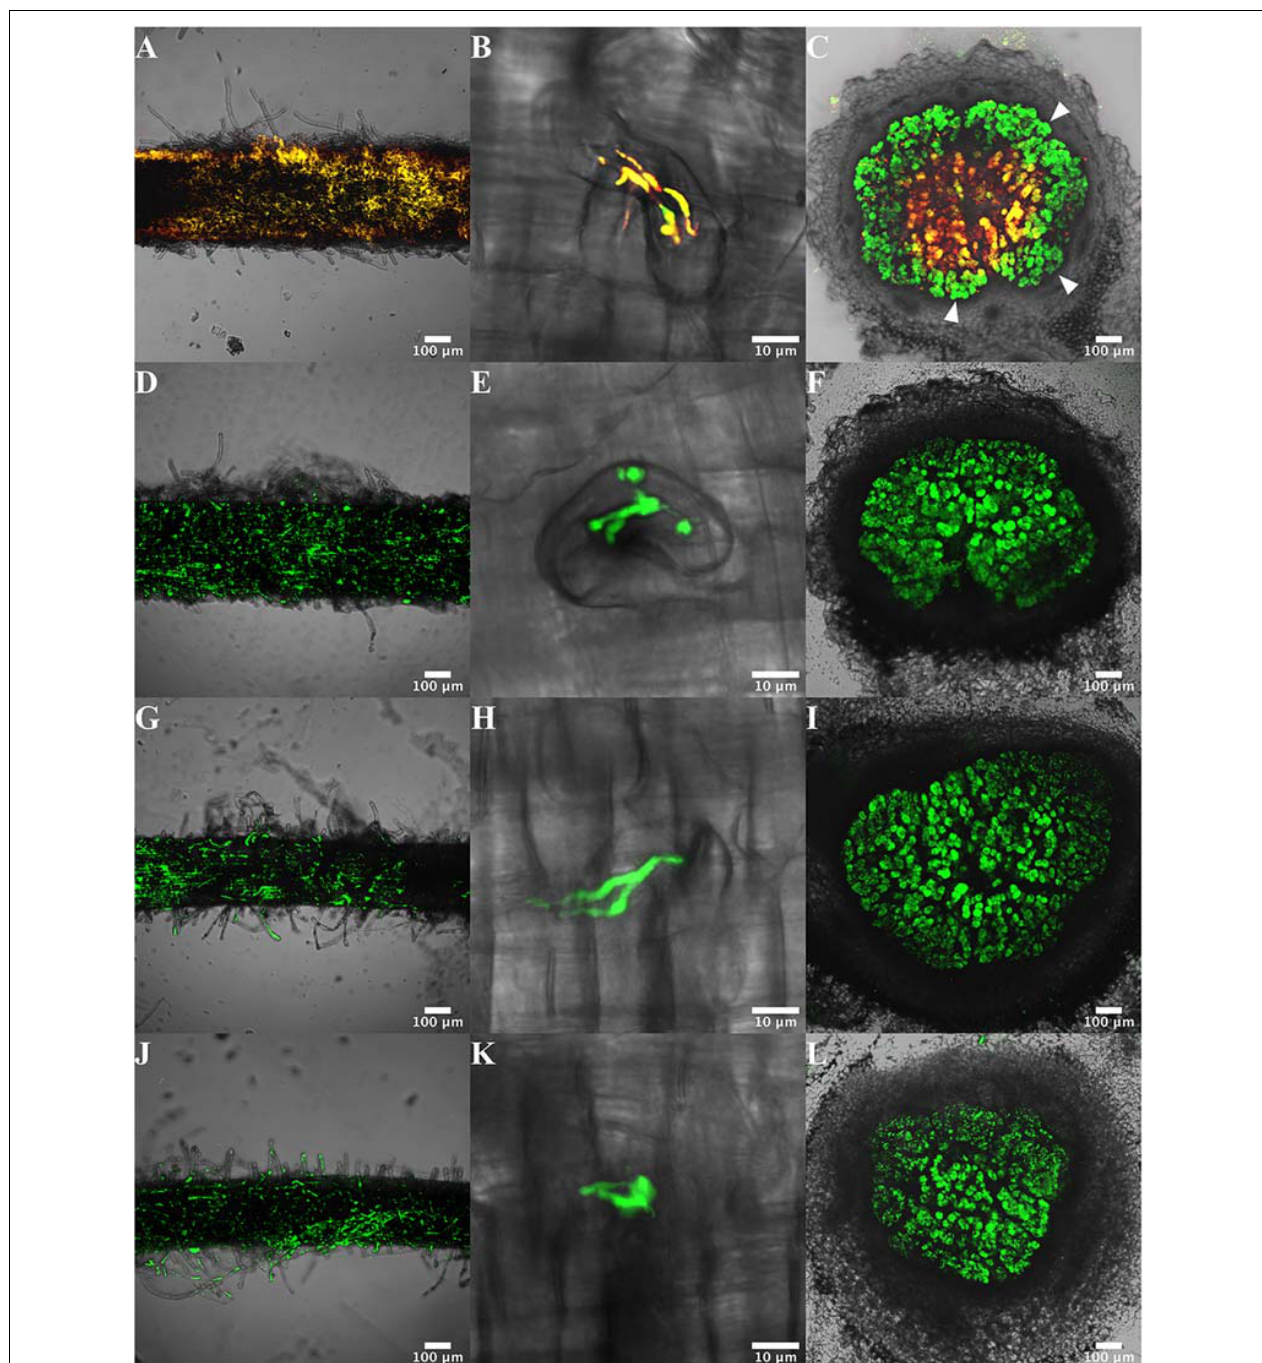
FIGURE 2 | Visualization of roots, infection threads and nodules of P. vulgaris plants infected with CFNX182-1 and TER strains. Plants were inoculated with the donor strain CFNX182-1 (A–C) , and with transconjugant strains TER31 (D–F) , TER38 (G–I) and TER49 (J–L) . Samples of the root surface (A,D,G,J) , infection thread (B,E,H,K), and nodules (C,F,I,L) were analyzed 21 dpi by confocal microscopy. CFNX182-1 is yellow (red plus green fluorescence) and transconjugants of endophytic recipients (TER) carry green fluorescence. Arrowheads indicate the localization of transconjugants (C) .